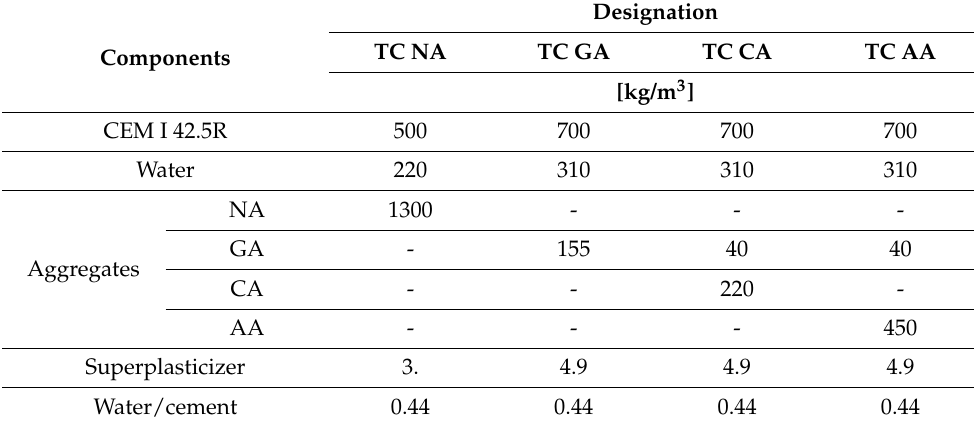
Table 4. Concrete mix